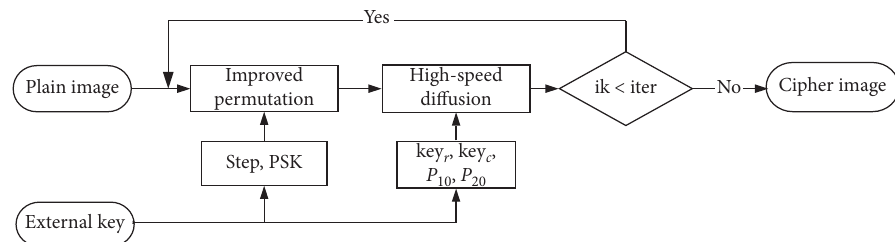
Figure 5: The flowchart of the proposed image encryption